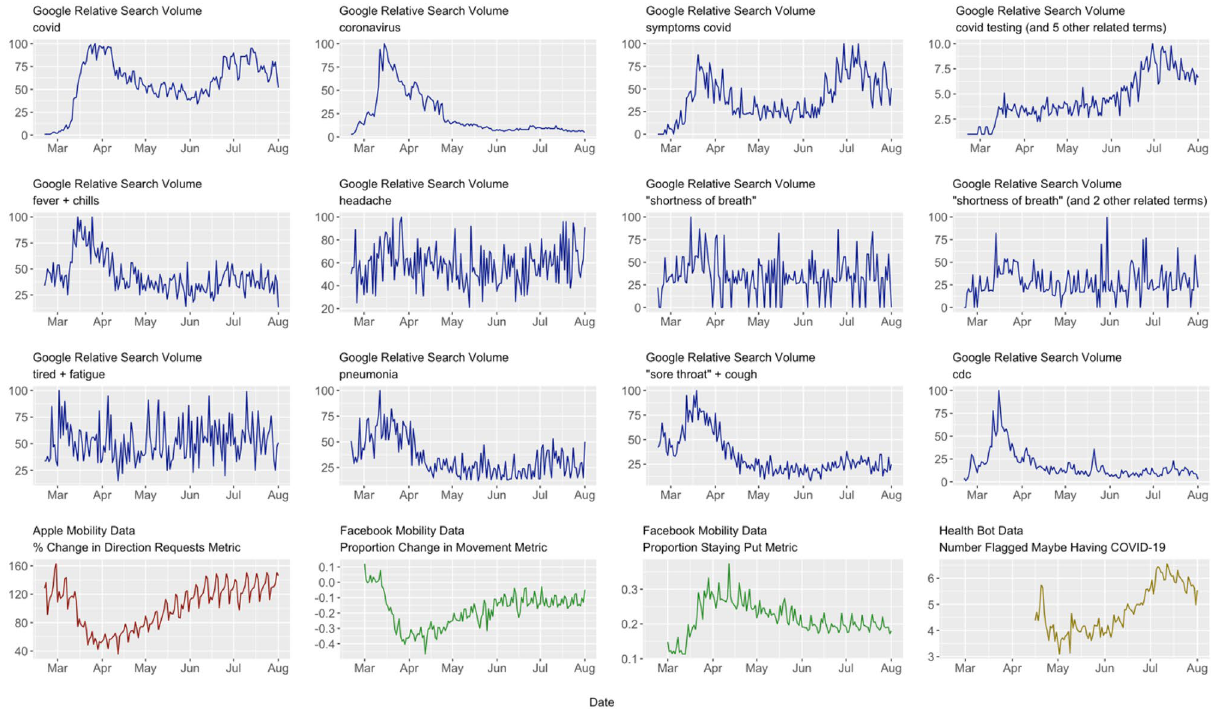
Figure 1. Time plots for internet variables used in data analysis.